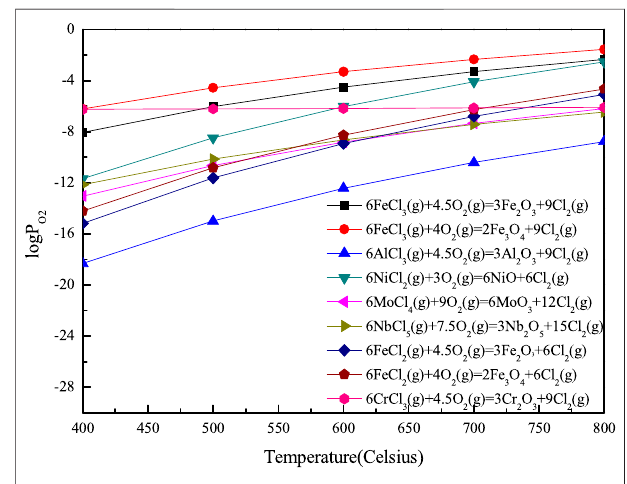
FIGURE 12 | Partial pressure of oxygen required for oxidation of metal chlorides to metal oxides at 400 – 800 ° C calculated by combination of Van ’ t Hoff isothermal equation and